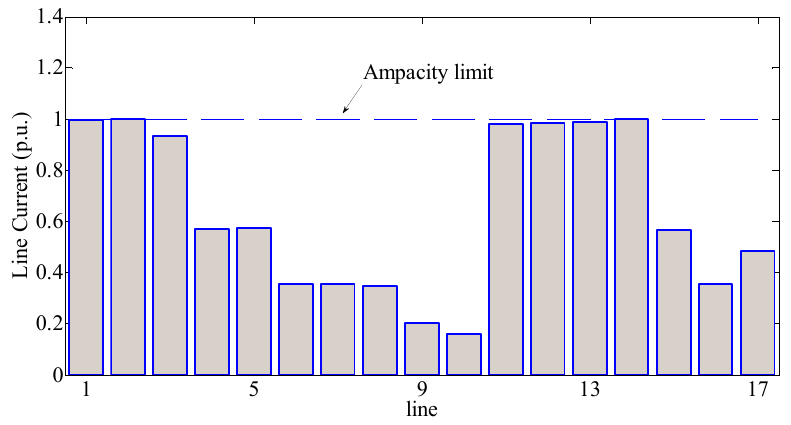
Figure 10. Case Study 3: Unbalance factor at each hour of the last typical day.